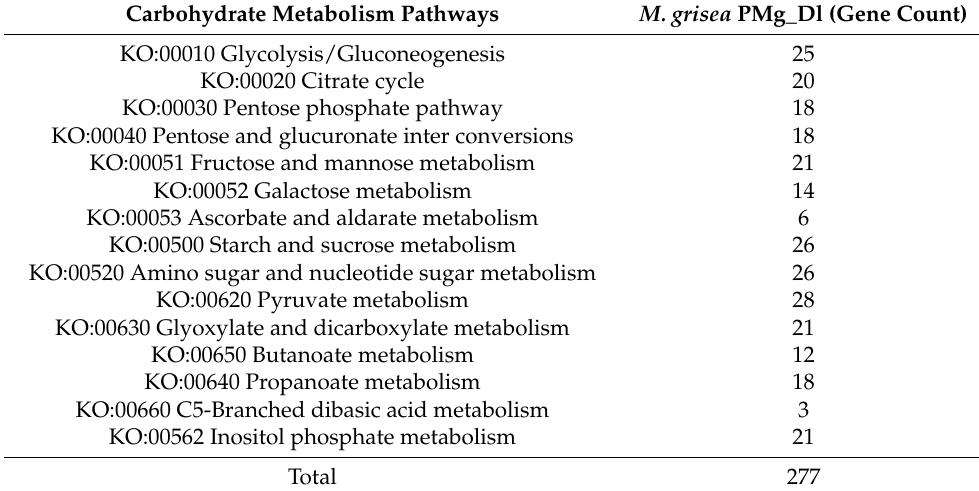
Table 4. Carbohydrate metabolism KEGG (Kyoto Encyclopedia of Genes and Genomes) pathway for M. grisea